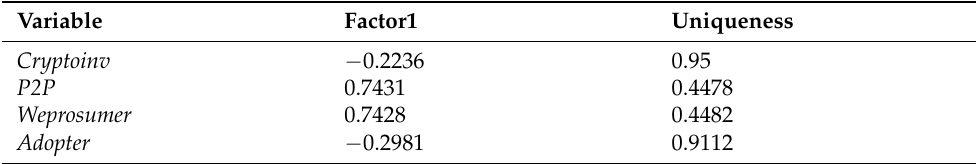
Table 5. Uniqueness of Main